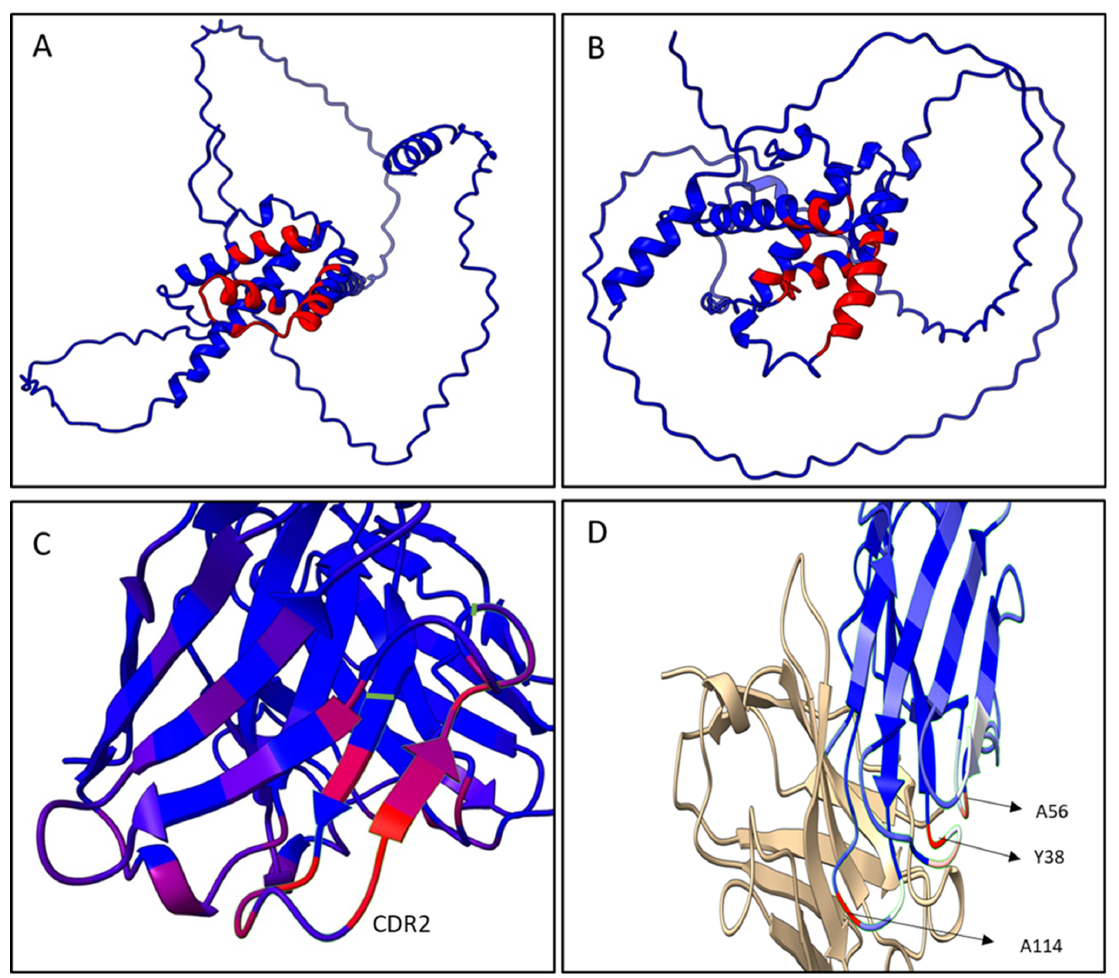
Figure 6. Epitope prediction ( A , B ) in α / β -gliadin ( A ) and γ -hordein ( B ) facing Fab8E-4. The residues colored in red are more likely to be part of the conformational epitope. Notice that the images have been rotated to show the conformational epitope. Models generated with EpiPred (SAbPred server). Paratope prediction in Fab8E-4 ( C , D ). The residues are colored according to the likelihood of being part of the paratope following the order: red >white >blue. Notice that the images have been rotated to show the zones with a higher likelihood of being part of the paratope. The model was generated with antibody i-patch (SAbPred server). ( C ) In red the residues of the heavy chain identified to be more likely to interact with the antigen. CDR2 and neighboring sequences in a green silhouette. ( D ) In red the residues of the light chain identified to be more likely to interact with the